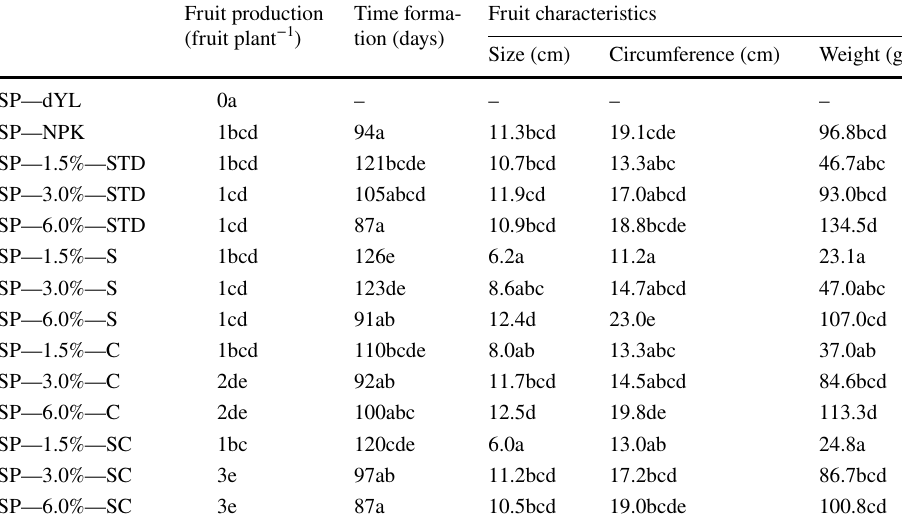
production on different substrates (SP—STD, SP—S, SP—C and SP—SC), the reference sample (SP—NPK) and the control sample (SP—dYL) (mean, ANOVA bootstrap, p < 0.05, n =